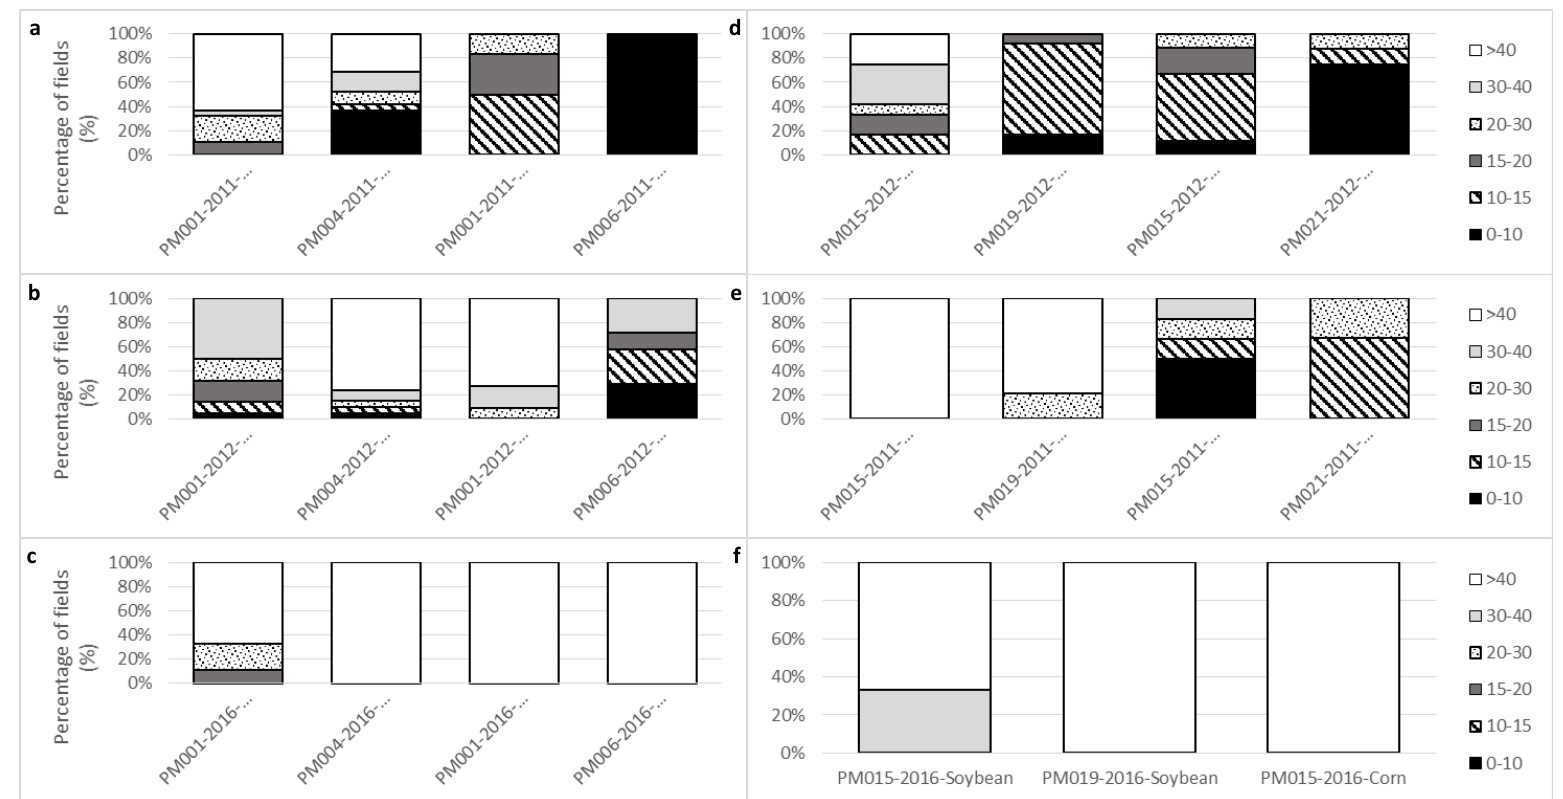
Figure 6. Overview of the performance of the ANN models, measured by the percentage of fields within di ff erent error ranges. Each stacked bar represents the percentage of fields within each RMAE % range (0–10; 10–15; 15–20; 20–30; 30–40; > 40). Figures ( a – c ) are results from models that were trained with 2011 data. Figures ( d – f ) are results from models that were trained with 2012 data. The model naming convention is as follows: PM001 = the model was trained and optimized for corn and soybean combined in 2011; PM004 = the model was trained and optimized for soybean only in 2011; PM006 = the model was trained and optimized for corn only in 2011. PM015 = the model was trained and optimized for corn and soybean combined in 2012; PM019 = the model was trained and optimized for soybean only in 2012; PM021 = the model was trained and optimized for corn only in 2012. The year indicates the application or test year, and the crop indicates which crop type’s yield was predicted. For example, PM006-2012-Corn = the model was trained with corn data from 2011, and applied on input variables from 2012 to predict corn yield in